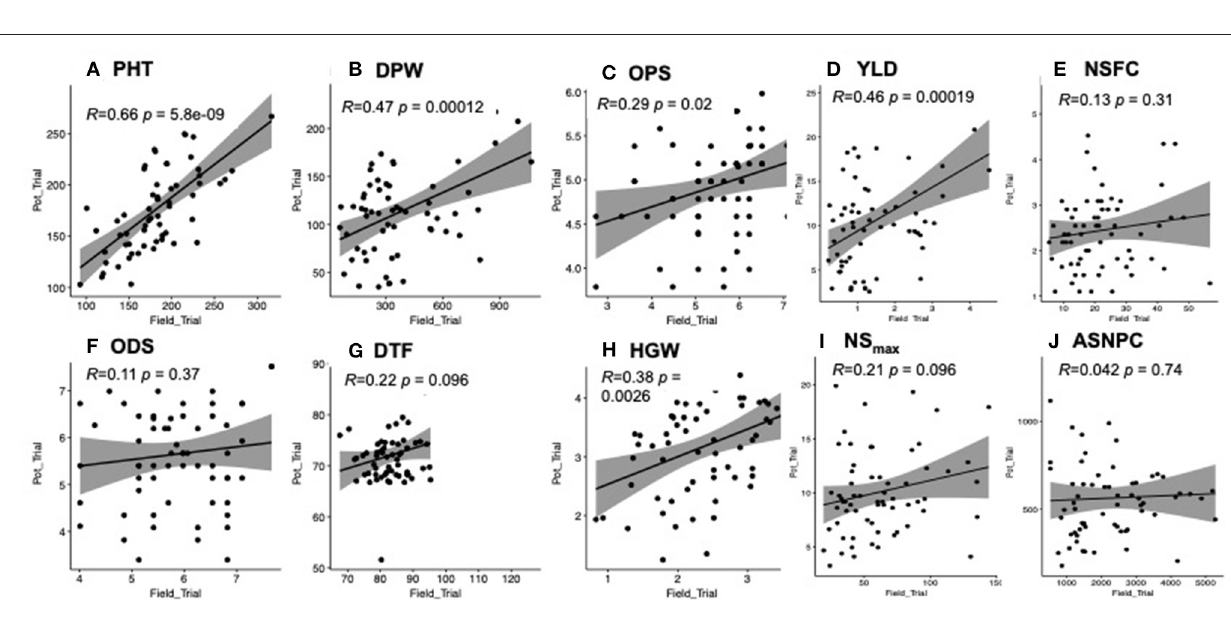
HGW) were consistently higher in the pot trial than in the field trial, while Striga -related traits (i.e., ASNPC and NS max ) ( Figure 1